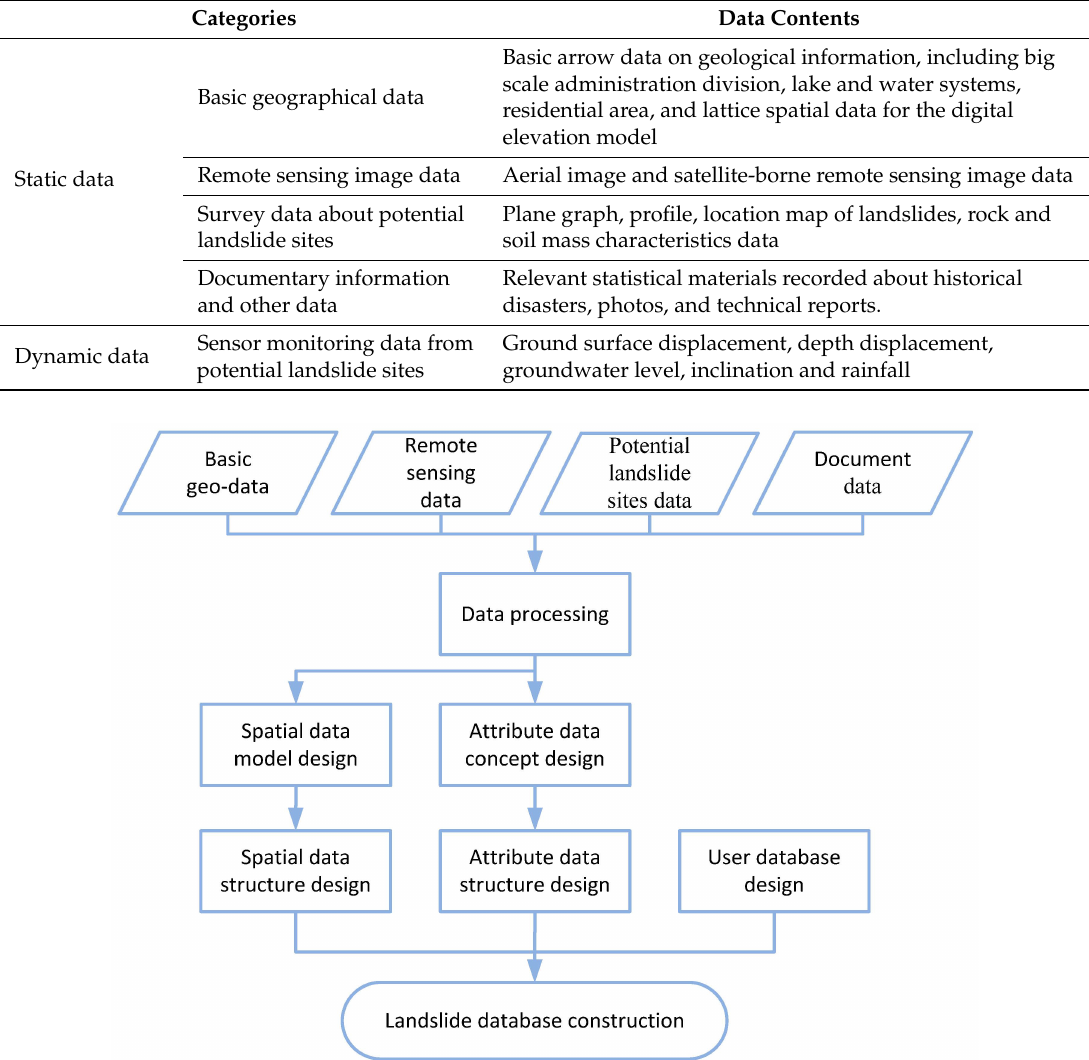
Figure 3. Flow-chart of database